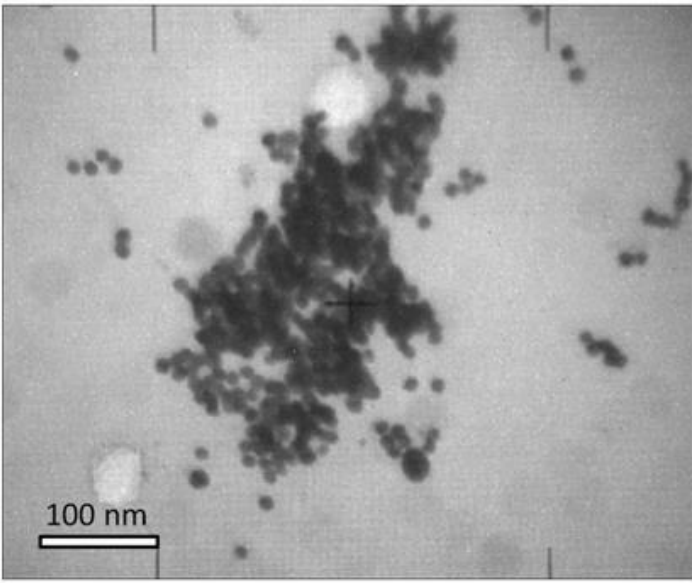
Figure 2. TEM micrograph of nanodiamonds used in this study.